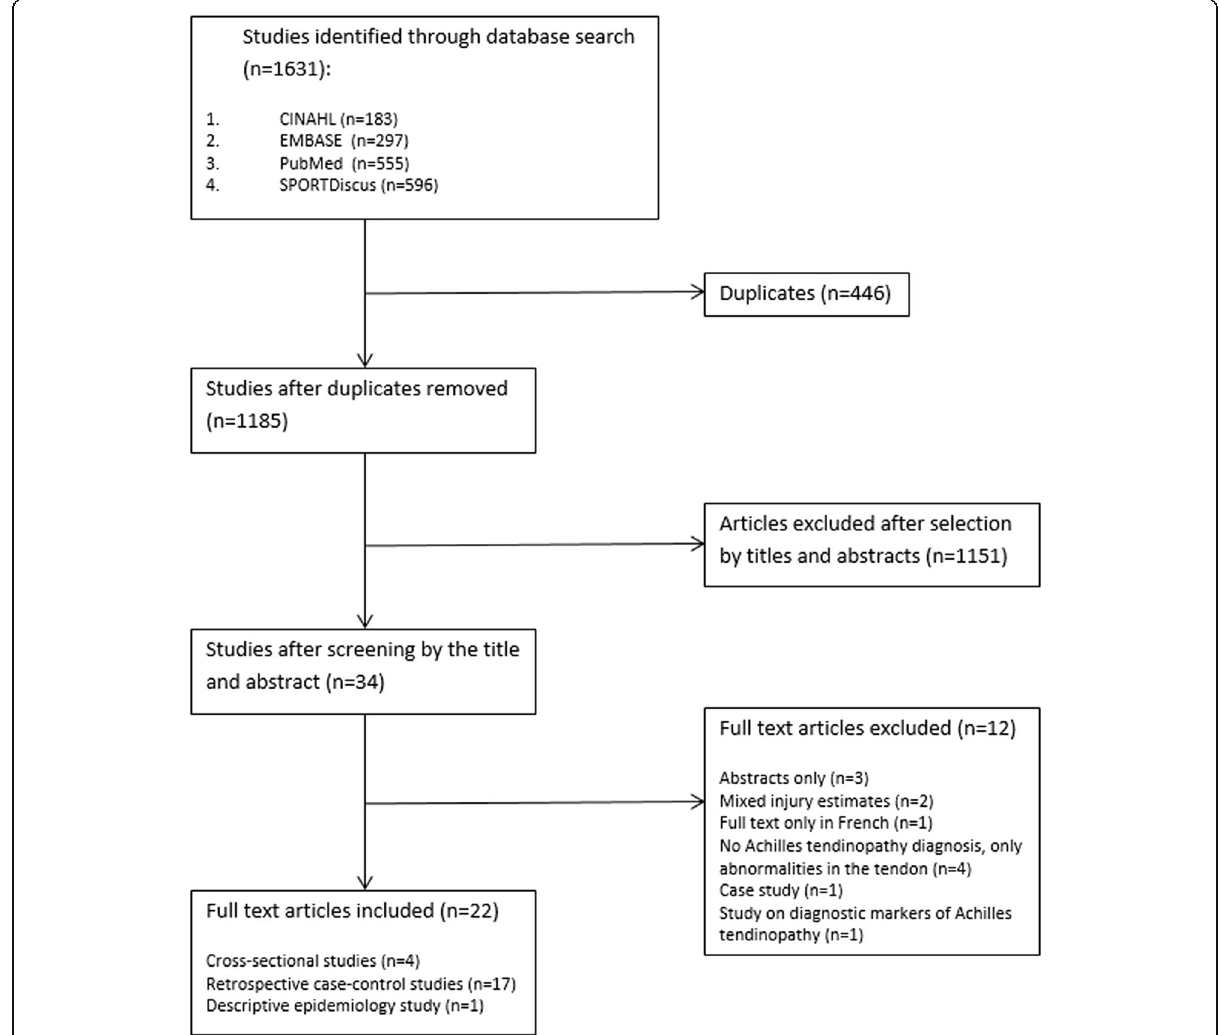
Fig. 1 PRISMA flowchart of the study selection